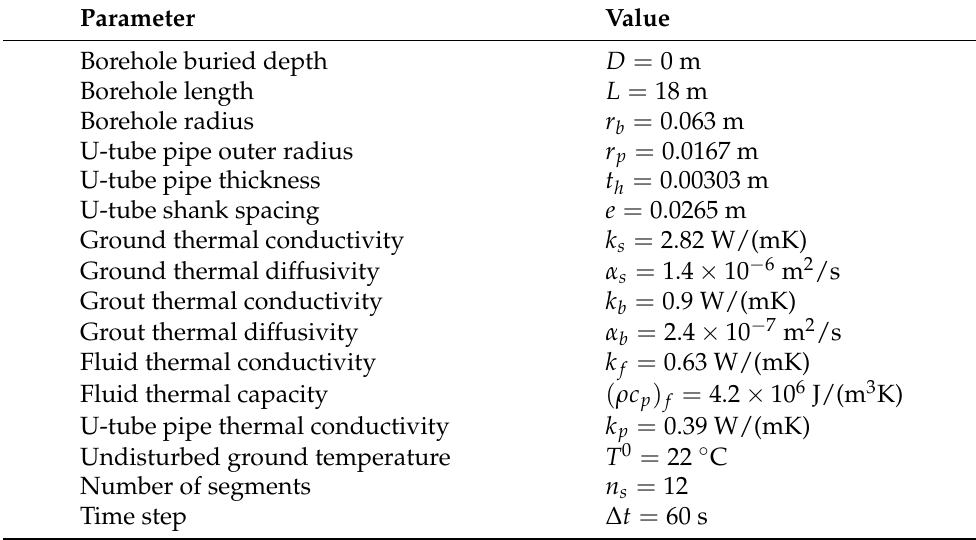
Table 1. Sandbox test